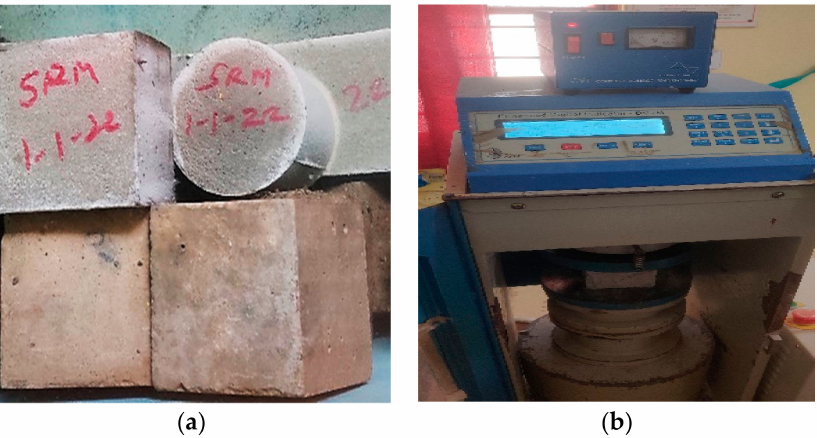
Figure 4. ( a ) Cube and Cylinder Specimens of FC., ( b ) Compressive Testing